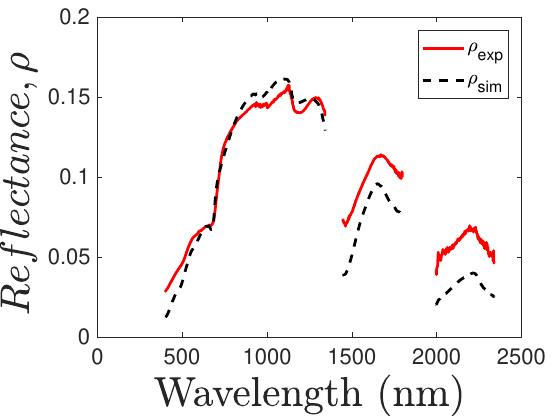
Figure 3. Example of simulated signatures of S. densiflorus reflectances obtained using the PROSAIL model and an iterative minimization method performed as explained in Sec. 2.4. ρ exp is plotted in red and ρ sim in black The simulated LAI values correlate with the measured value in each signature (coefficient of correlation r = 0 . 82 ). The para- meter distributions obtained from the simulated reflectances are shown in Fig. 4.